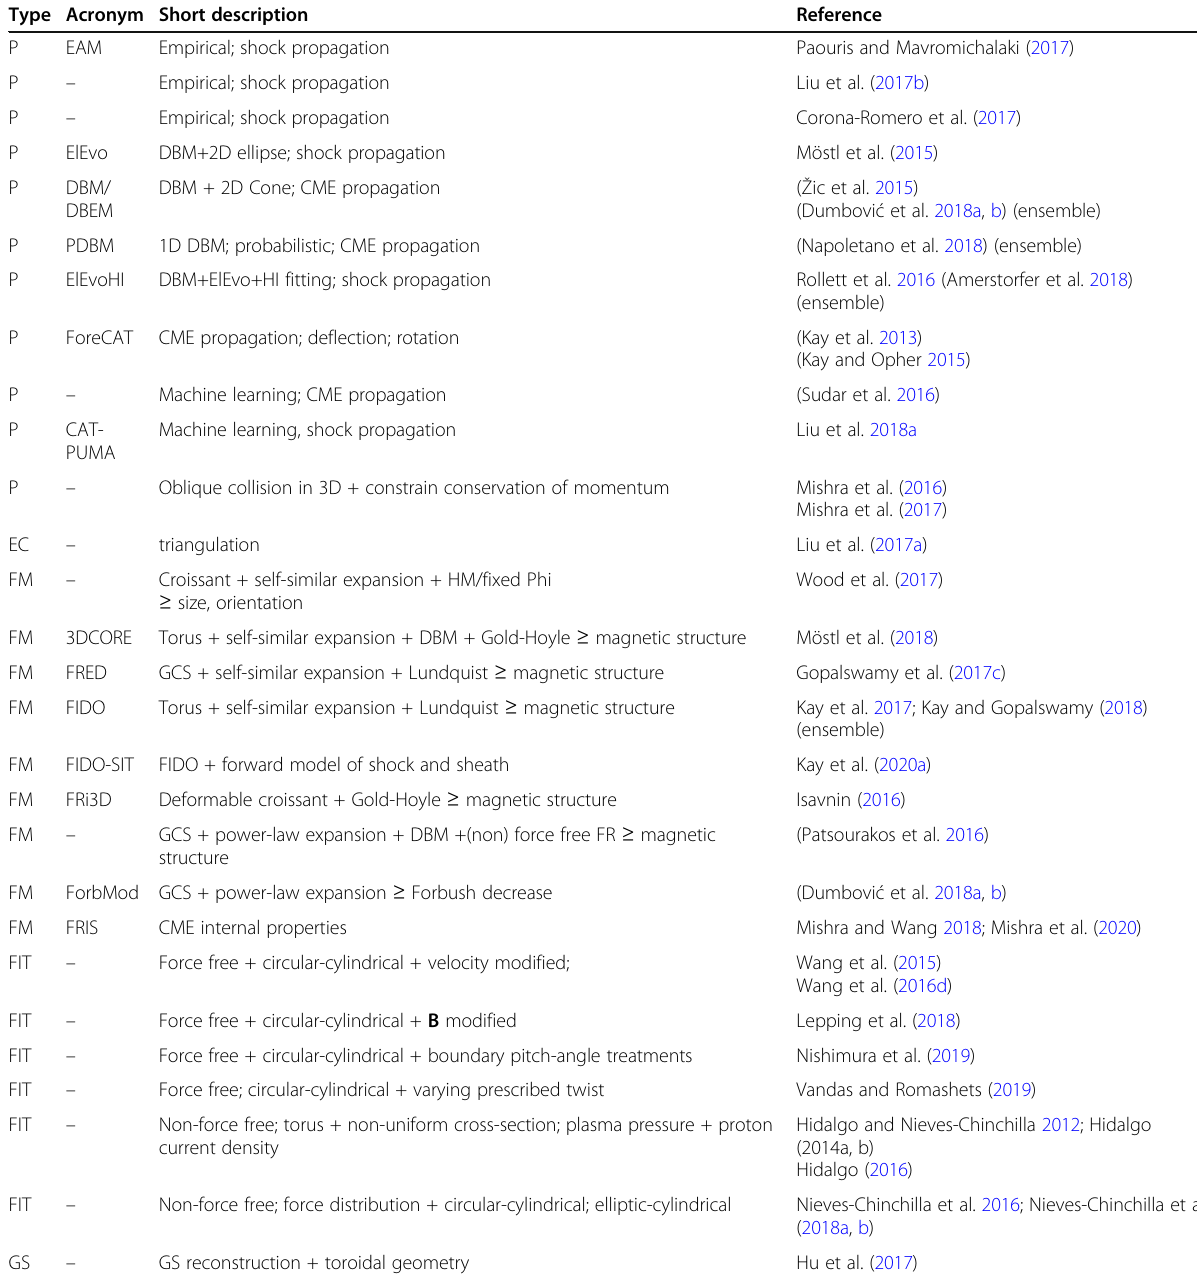
Table 4 List of recent analytical and semi-empirical models of CMEs/ICMEs Type Acronym Short